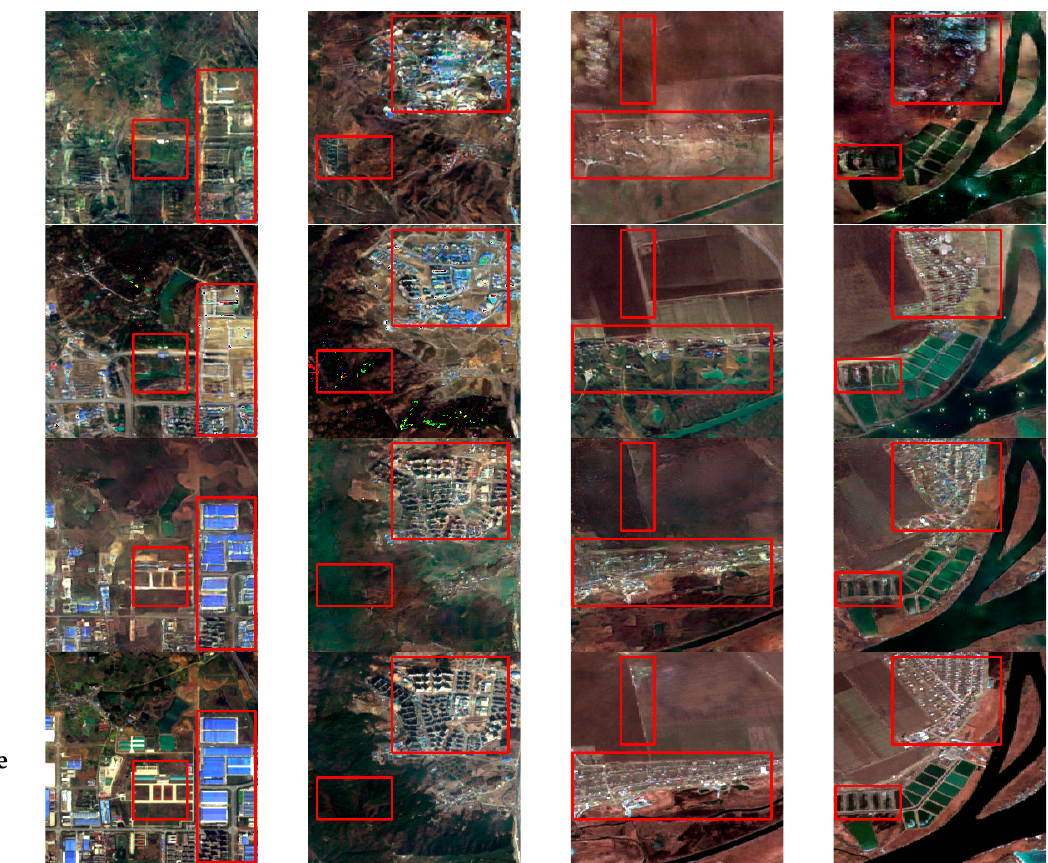
Figure 7. A visual comparison of different SAR-to-optical methods. The size of all images is 256 × 256.